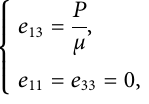
Frontiers in Earth Science |